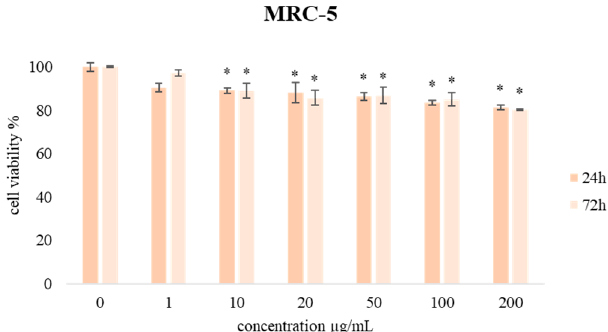
Figure 3. The effects of six concentrations of CSEO on MRC-5 cell viability after 24 h and 72 h of treatment. Results are presented as the mean of three independent experiments ± standard error; * p < 0.05 relative to control.